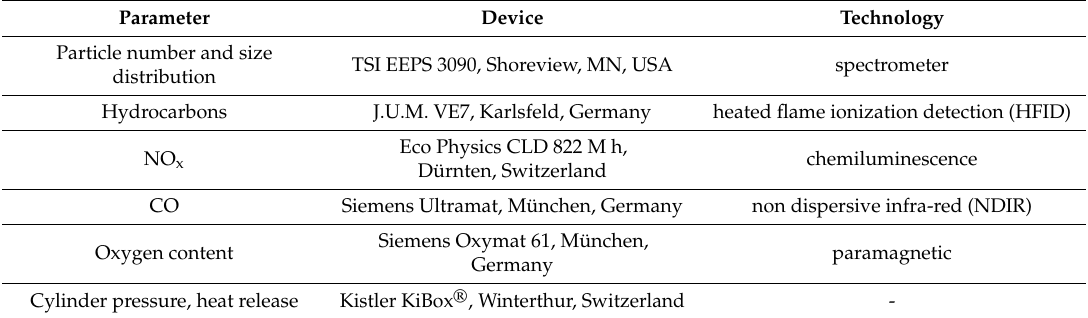
Table 3. Measuring equipment for gaseous emissions.